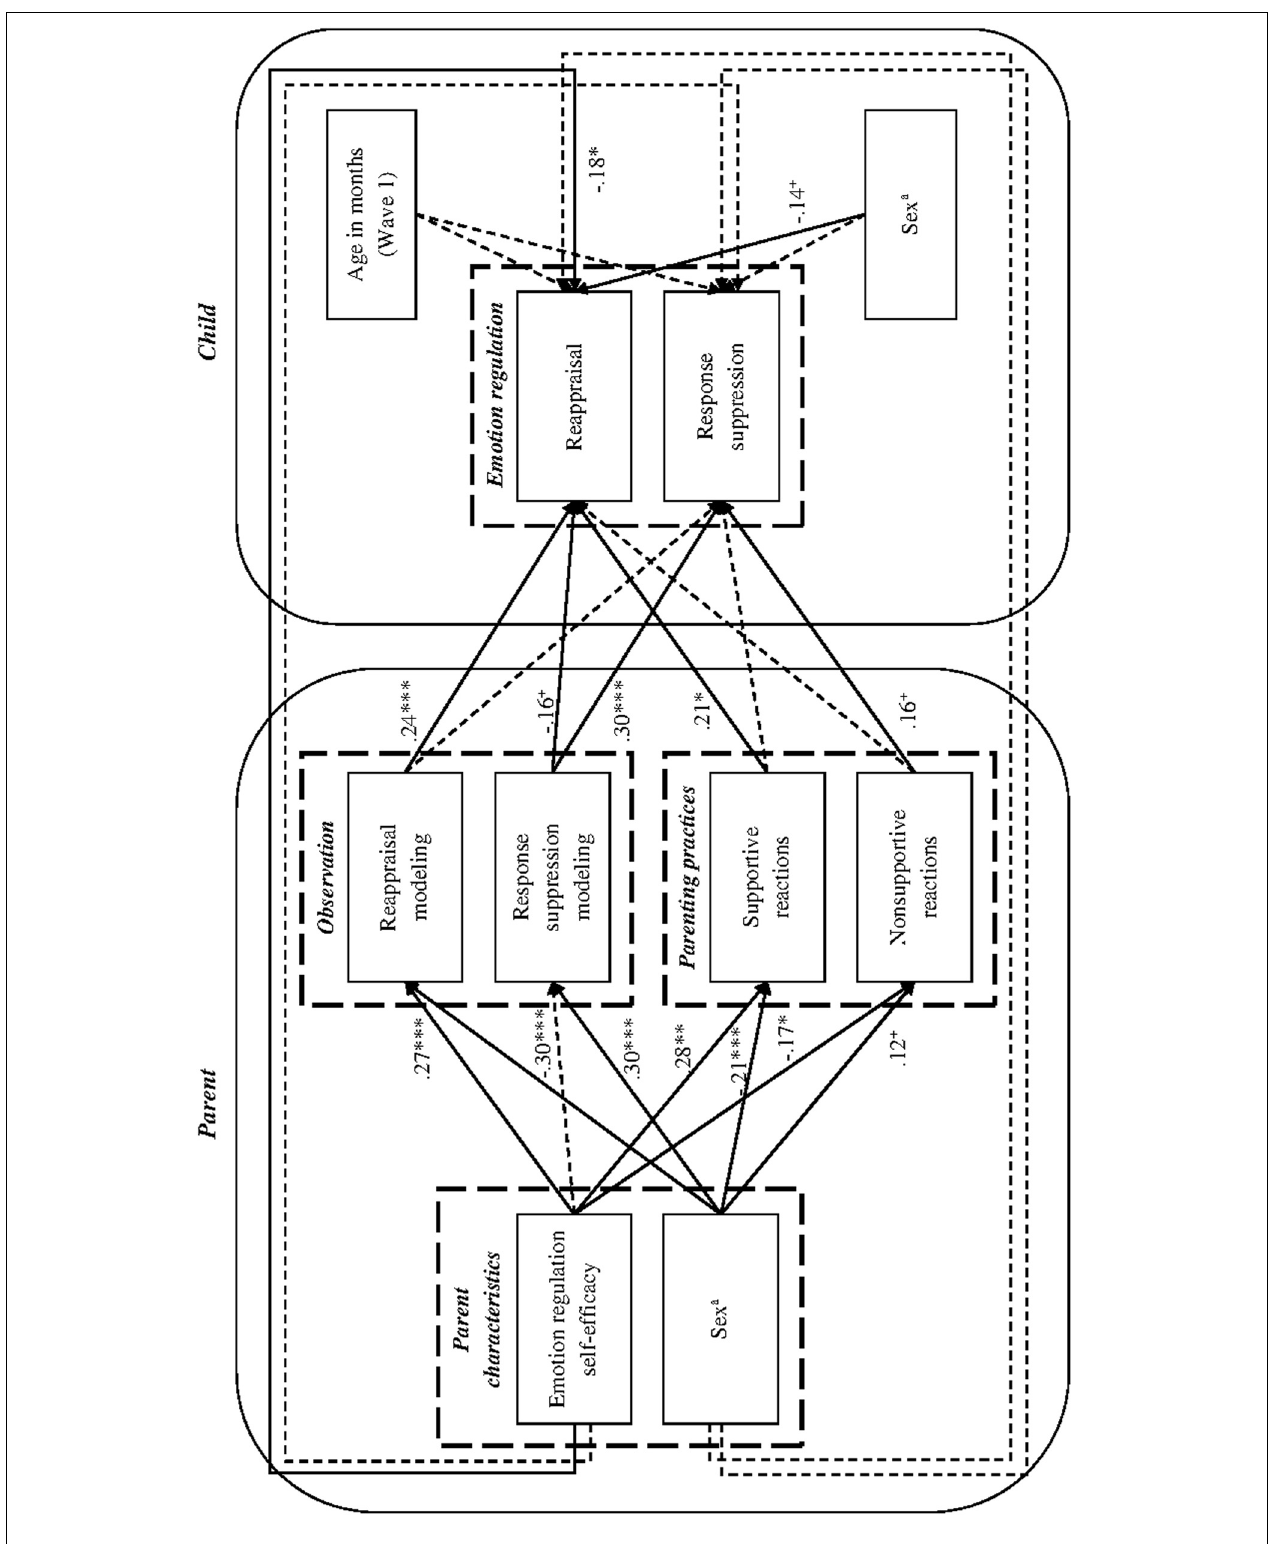
FIGURE 2 | Direct and indirect relations between parents’ emotion-regulation self-efficacy, socialization components, and children’s use of emotion regulation strategies. a 0 = female and 1 = male. Solid lines represent significant effects; dashed lines represent non-significant effects. Covariances are not displayed in the